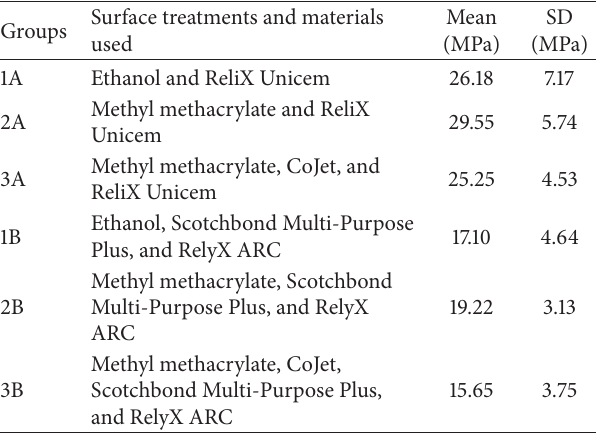
Table 2: Mean and SD values of the pull-out test. Surface treatments and materials Groups used